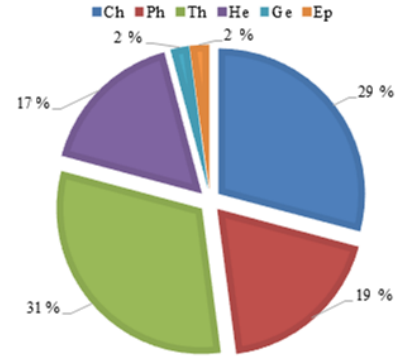
Figure 7. Plant life-forms in the study area.